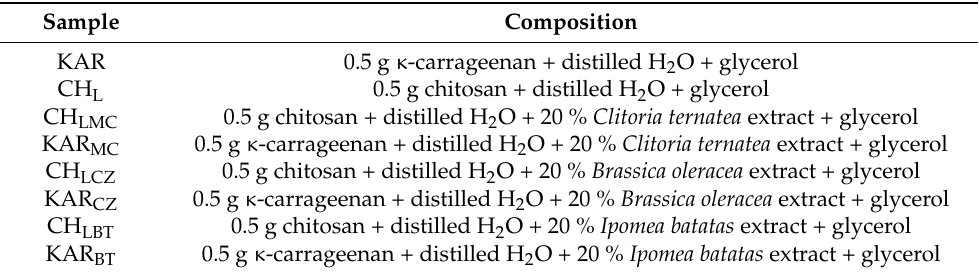
Table 1. Composition of prepared edible